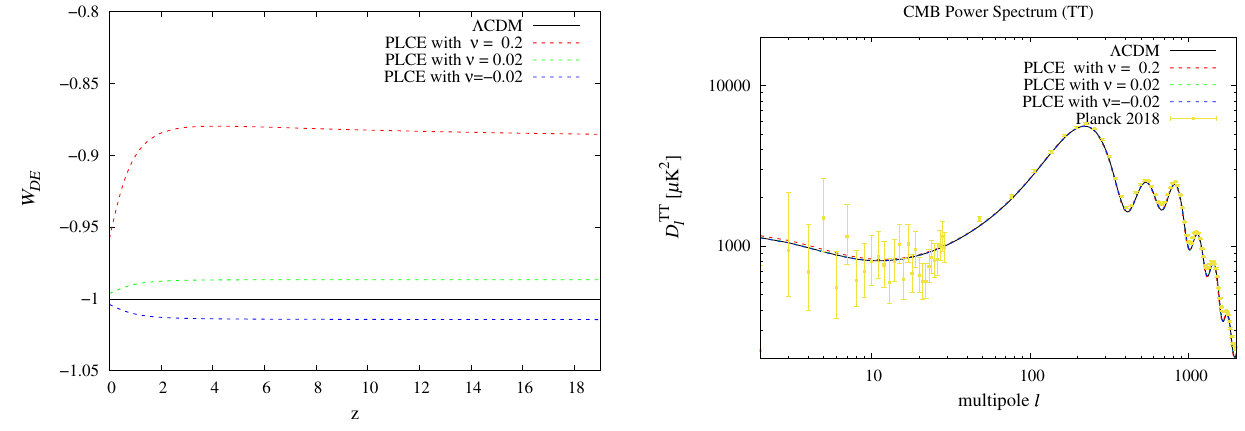
Fig. 2 CMB power spectra of the TT mode in (cid:2) CDM and PLCE mod- els along with the Planck 2018 data